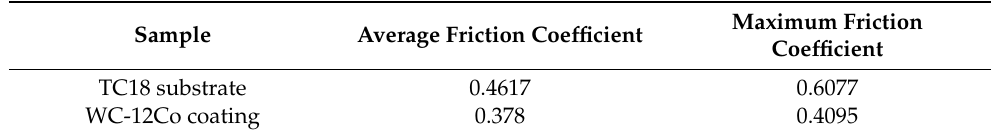
Table 8. Friction coefficients of the substrate and the coating sample.